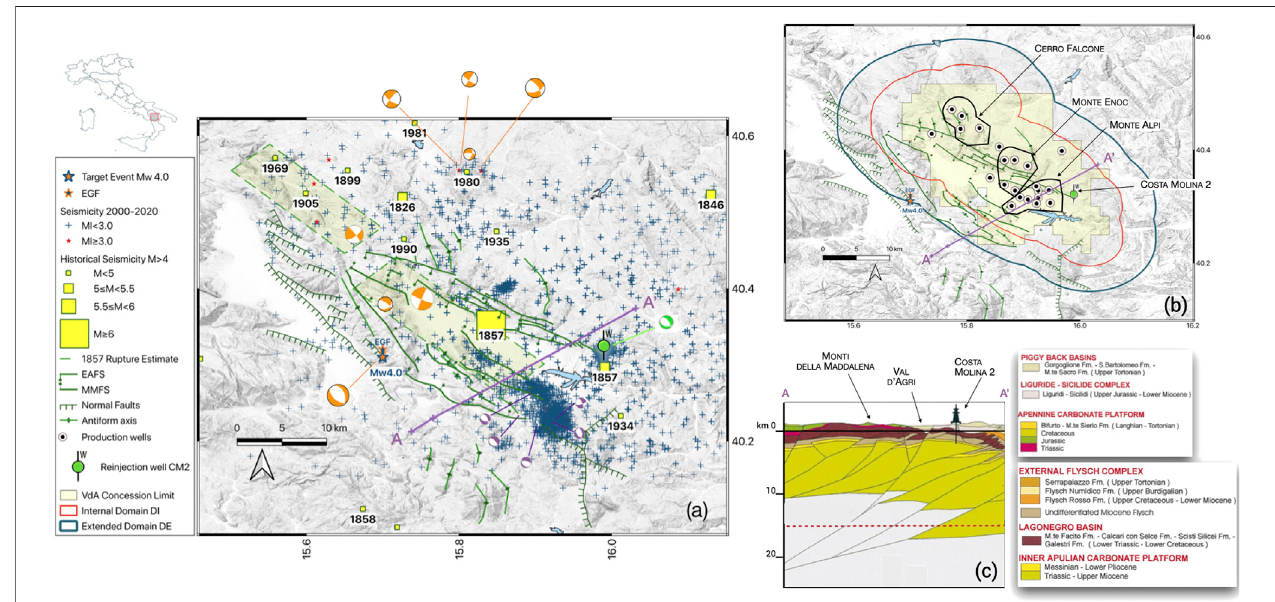
FIGURE 1 | General information and reference map of the study area. (A) The large orange star indicates the target event and the smaller star (inverted colors) indicates the single aftershock used as the empirical Green ’ s function (EGF); the corresponding orange beachball represents the moment tensor (MT) solution released byINGV.OtherorangebeachballsshowregionalMT(Cuccietal.,2004);purplebeachballsshowtheMTofafewMl ∼ 2events(Improtaetal.,2017);thegreenbeachball is a representative MT of the seismicity linked to the Costa Molina 2 (CM2) reinjection well. Geological features are in accordance with Valoroso et al. (2011, and references therein: the Eastern Agri Fault System (EAFS) and the Monti della Maddalena Fault System (MMFS). Blue crosses show the recorded seismicity in the timespan 2001 – 2020, red starsare Ml > 3events. The mainhistorical events (yellowsquares)are extracted from CPTI15 (Rovida et al.,2019; Rovida et al.,2020);green dashed boxes indicate the potential causative sources of the 1857M ∼ 7 Earthquake (after Burrato and Valensise, 2008) (B) The yellow shaded area represents the Val d ’ Agri (VA) industrial concession; circled black dots mark the production wells. The red and blue boundaries indicate the internal and extended monitoring domains, respectively. CM2 is represented as in (A) . The pro fi le AA ′ follows Menardi Noguera and Rea (2000) (C) Schematic geologic cross-section across the VA basin was modi fi ed after Menardi Noguera and Rea (2000). The red dashed line represents the approximate limit of seismic data images.